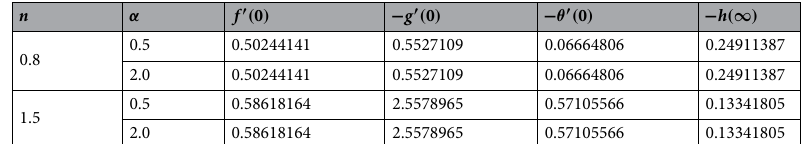
) for increasing power-law index n by taking h ( − ∞ 0.8 =